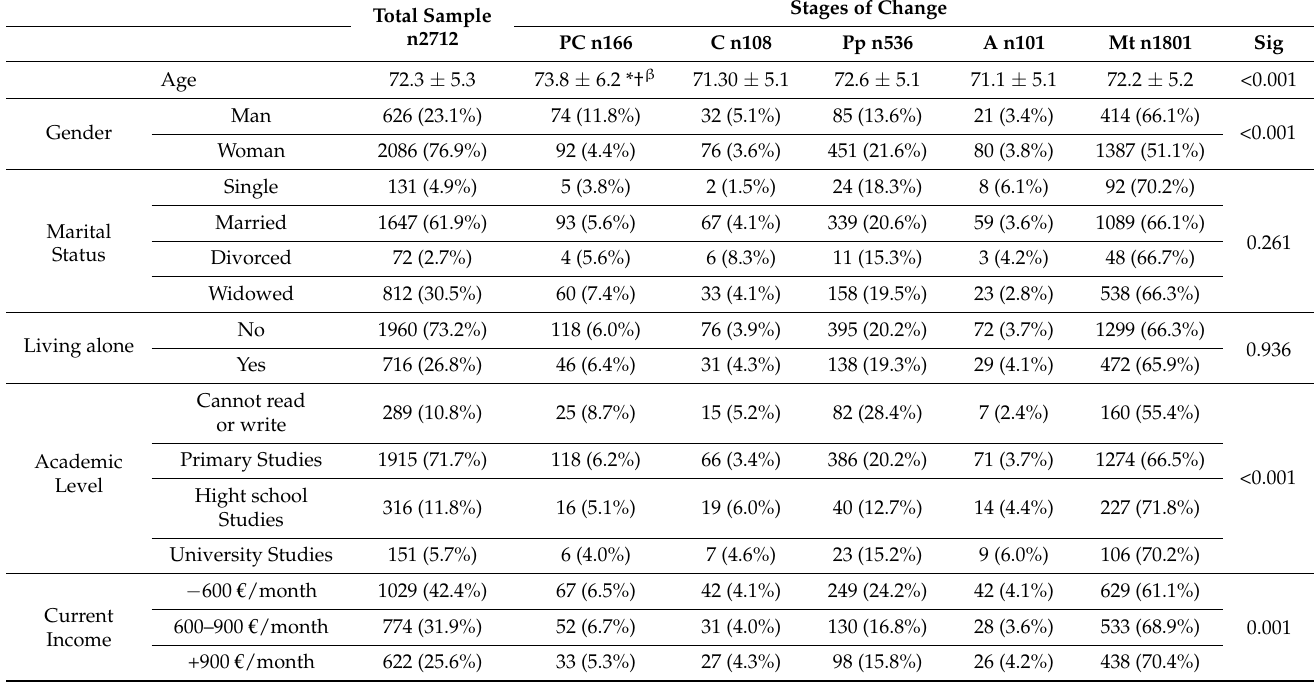
Table 1. Socio-demographic characteristics and stages of change for physical activity. Bivariate